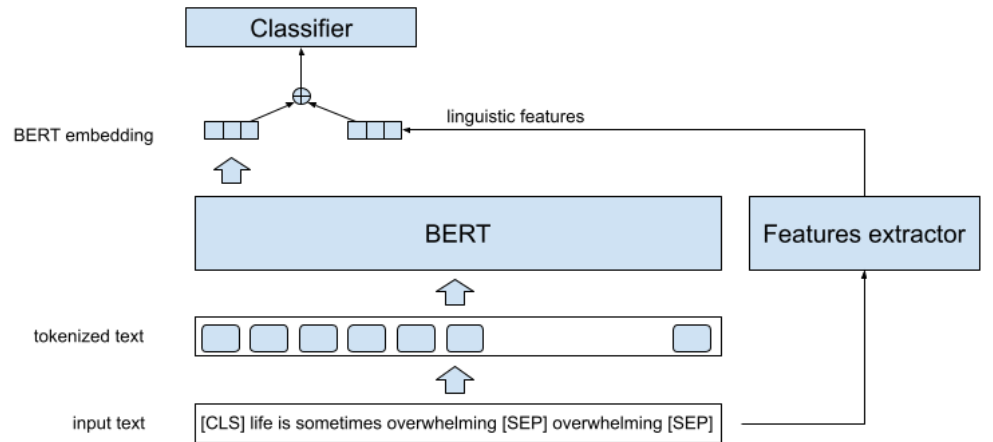
Figure 1. Architecture of the